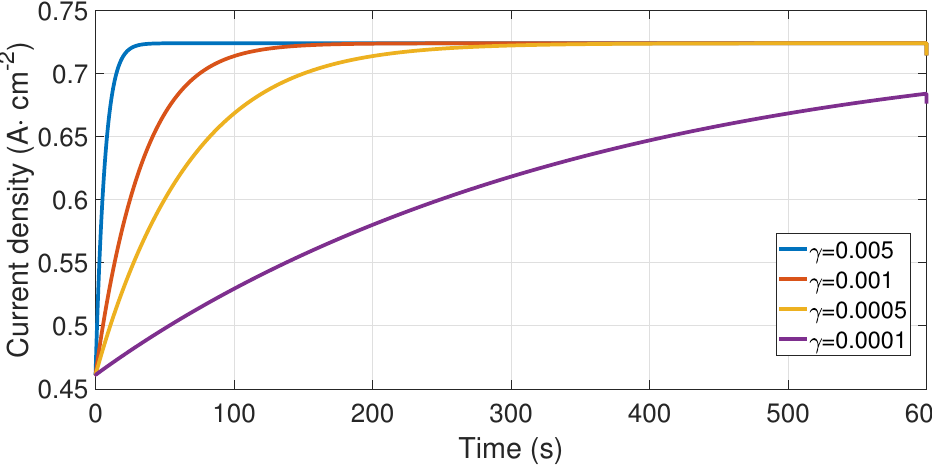
Figure 6. Simulation of electrical current density stability with different values γ .